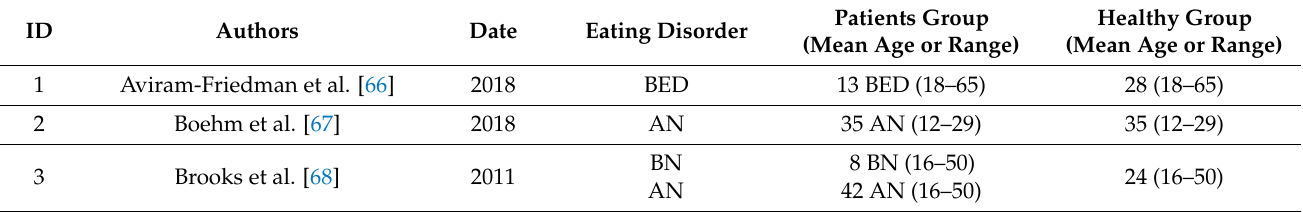
Table 1. Summary of included